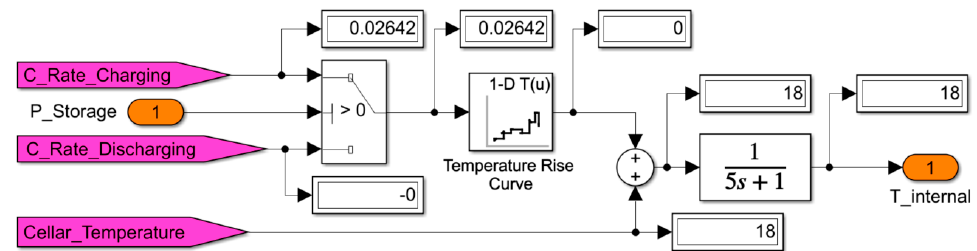
Figure 10. Estimation model for the internal LIB temperature.